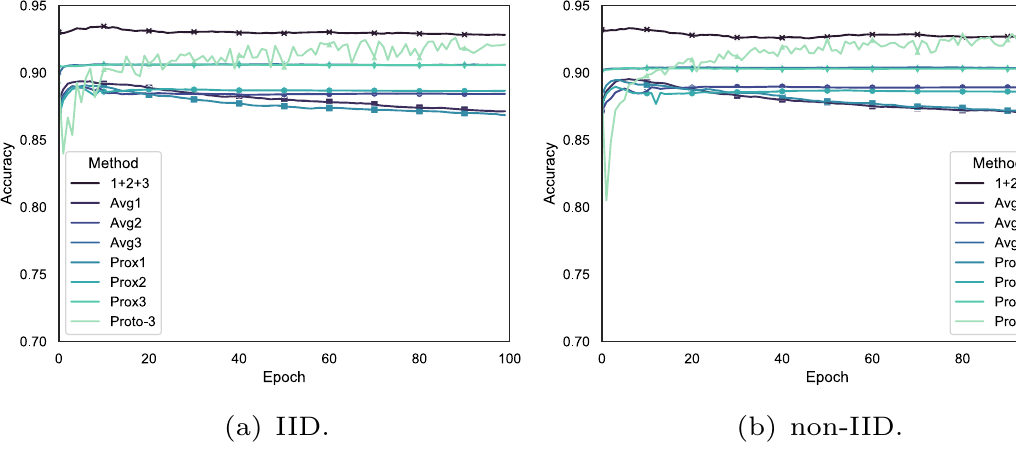
Fig. 11 Multi-level heterogeneity performance comparisons of multi-task FL under IID and non-IID